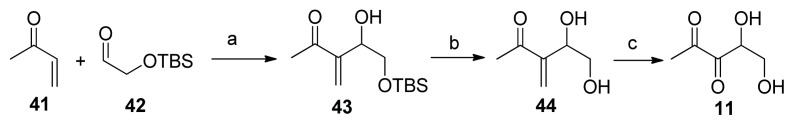
Doutheau’s synthesis of DPD. Regents and conditions: (a) THF, DABCO, 0 °C; (b) TBAF/THF, RT; (c) 1. O3, MeOH, −78 °C; 2. DMS, −78 °C to RT.